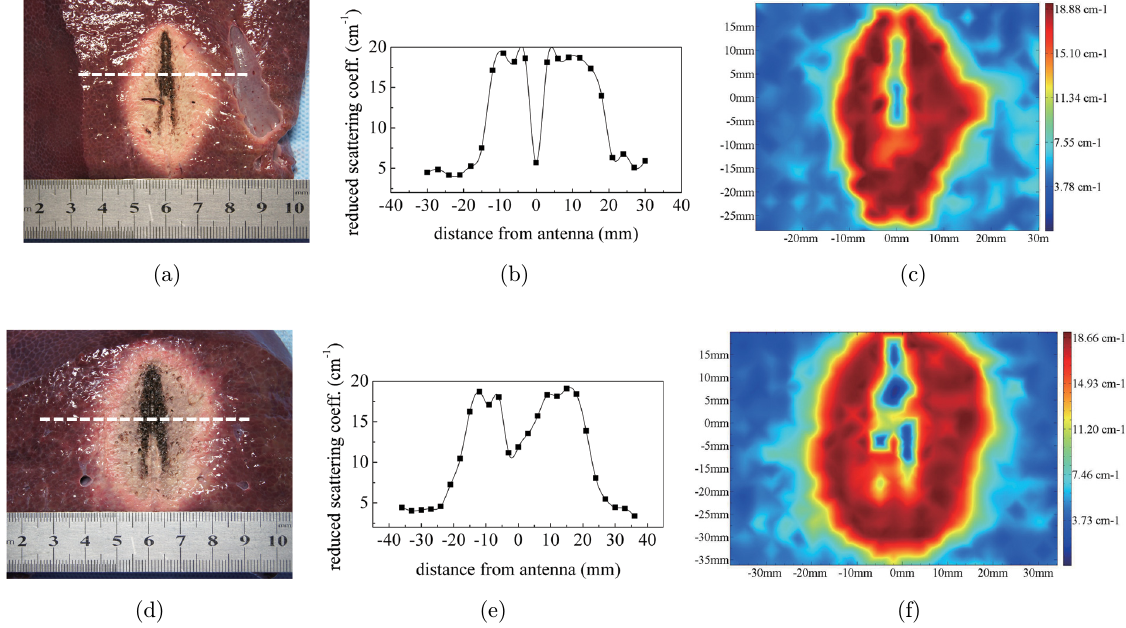
Fig. 4. Liver specimens ablated after 300 s (a) and 600 s (d) ablation with both 70 W microwave output power. (b) and (e) the (cid:1) 0 s changes along the white line in (a) and (d). (c) and (f) the distribution of (cid:1) 0 s along the whole ablated area surface of (a) and (d).